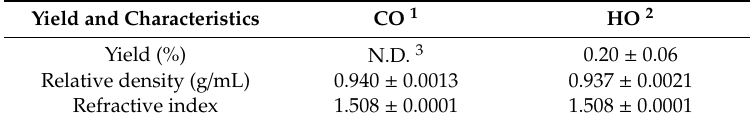
Table 1. Yield and characteristics of O. vulgare essential oils.